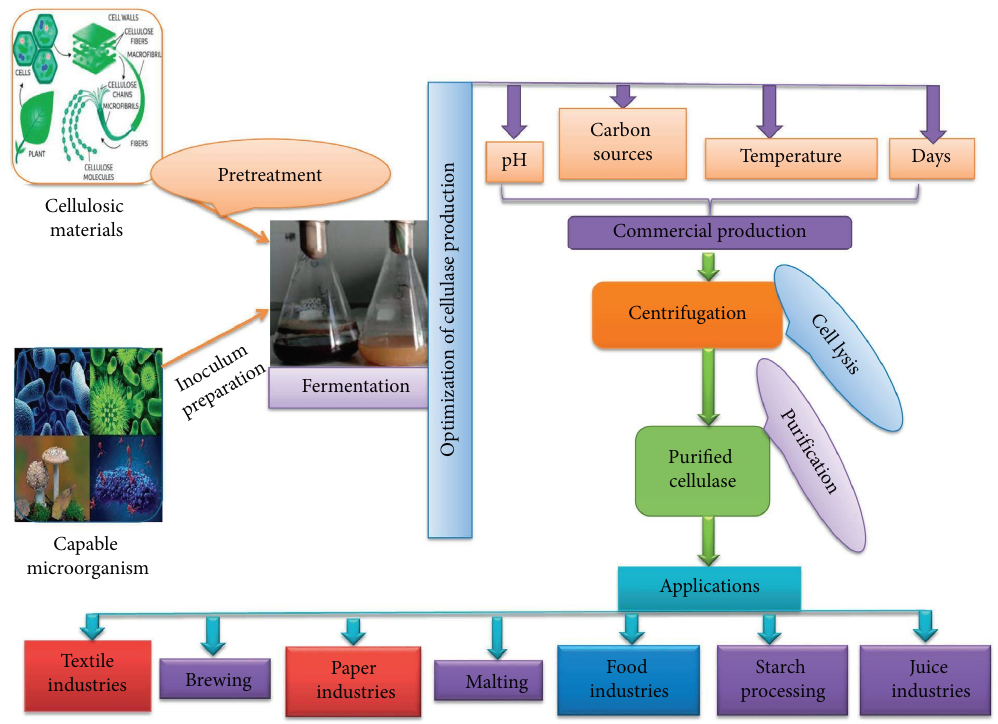
Figure 1: Diagrammatic representation of microbial cellulase production and its industrial